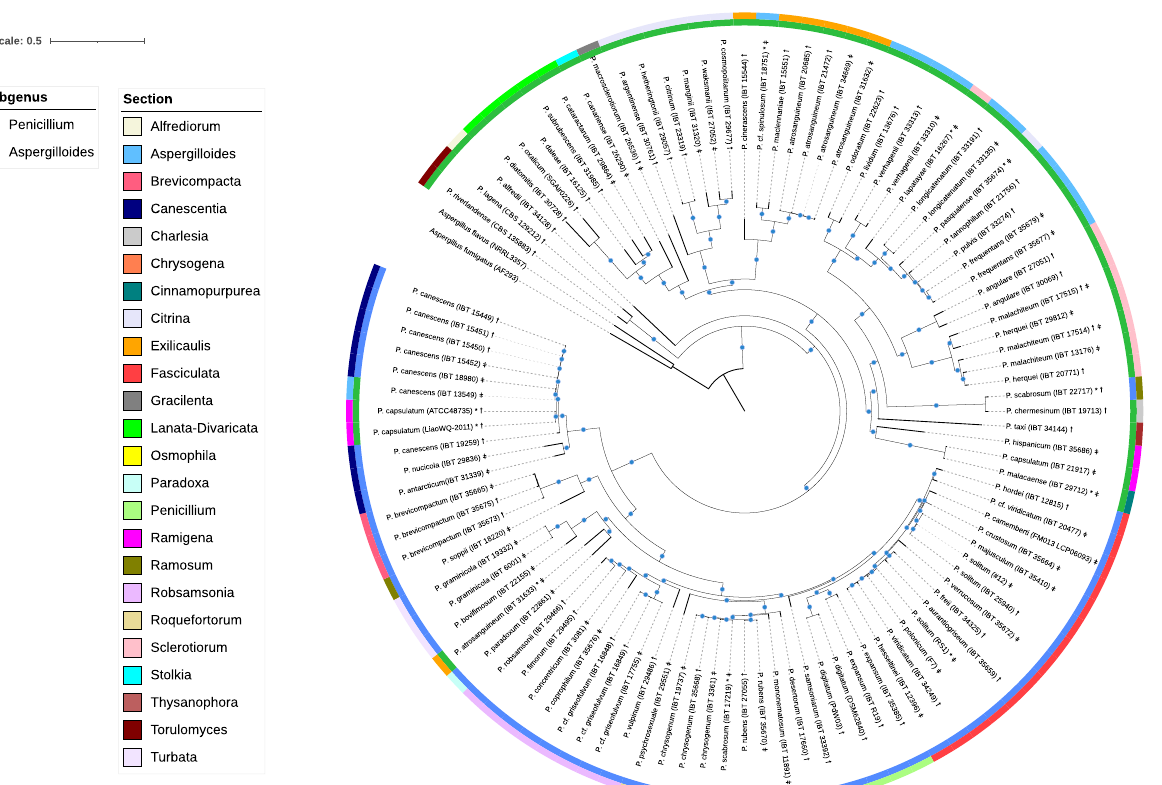
Fig. 2 Representation of the phylogenetic relationship between the 104 Penicillium isolates. The phylogeny is based on 1142 BUSCO families. Aspergillus fumigatus AF293 and Aspergillus flavus NRRL 3357 were chosen as outgroups. The inner circle is colored according to the subgenera whereas the outer circle is colored according to sections as described in Houbraken et al. (2020). The blue circles state nodes with a bootstrap value of 95%. The tree scale is amino acid substitutions per site. P. capsulatum (ATCC48735)* and P. solitum (RS1)* have been reidentified as P. canescens ≥ (ATCC48735) and P. polonicum (RS1), respectively by Houbraken et al . (2021). Asterisk indicates isolates that have been misclassified. ꝉ and ǂ list mating type MAT1-1 and MAT1-2,